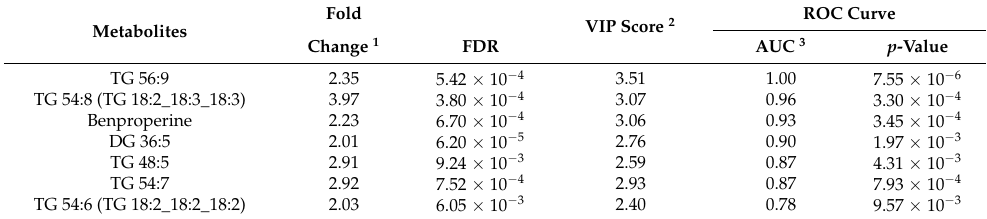
Table 2. Fold change, variance importance in projection score and receiver operating characteristics curve for the significant plasma metabolites after participants consumed the SO- and PHSO-enriched diets.